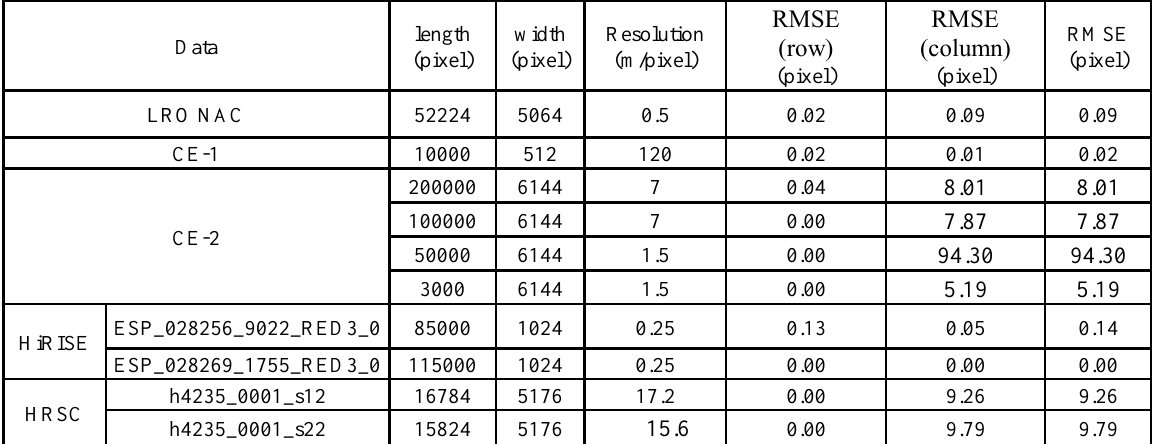
Table 1. Residuals of traditional RFM fitting of different planetary orbiter